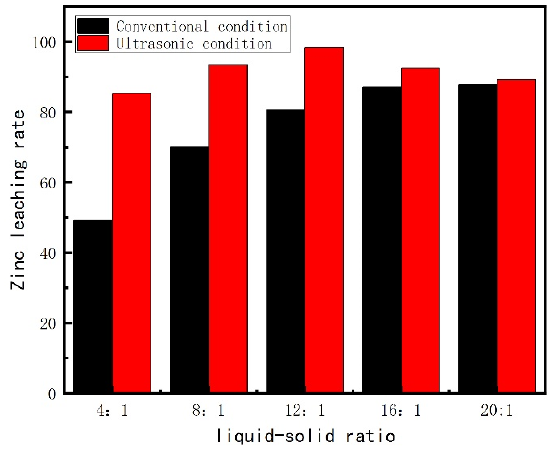
Figure 9. Effect of liquid-solid ratio on the zinc leaching rate; conventional: leaching temperature = 60 ◦ C, leaching time = 240 min, stirring speed = 400 rpm, ultrasonic: leaching temperature = 60 ◦ C, leaching time = 240 min, ultrasonic power = 450 W.